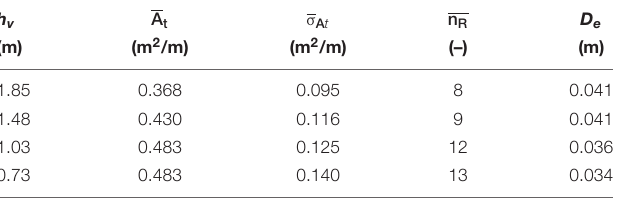
TABLE 2 | Mean projected area per unit height per tree.